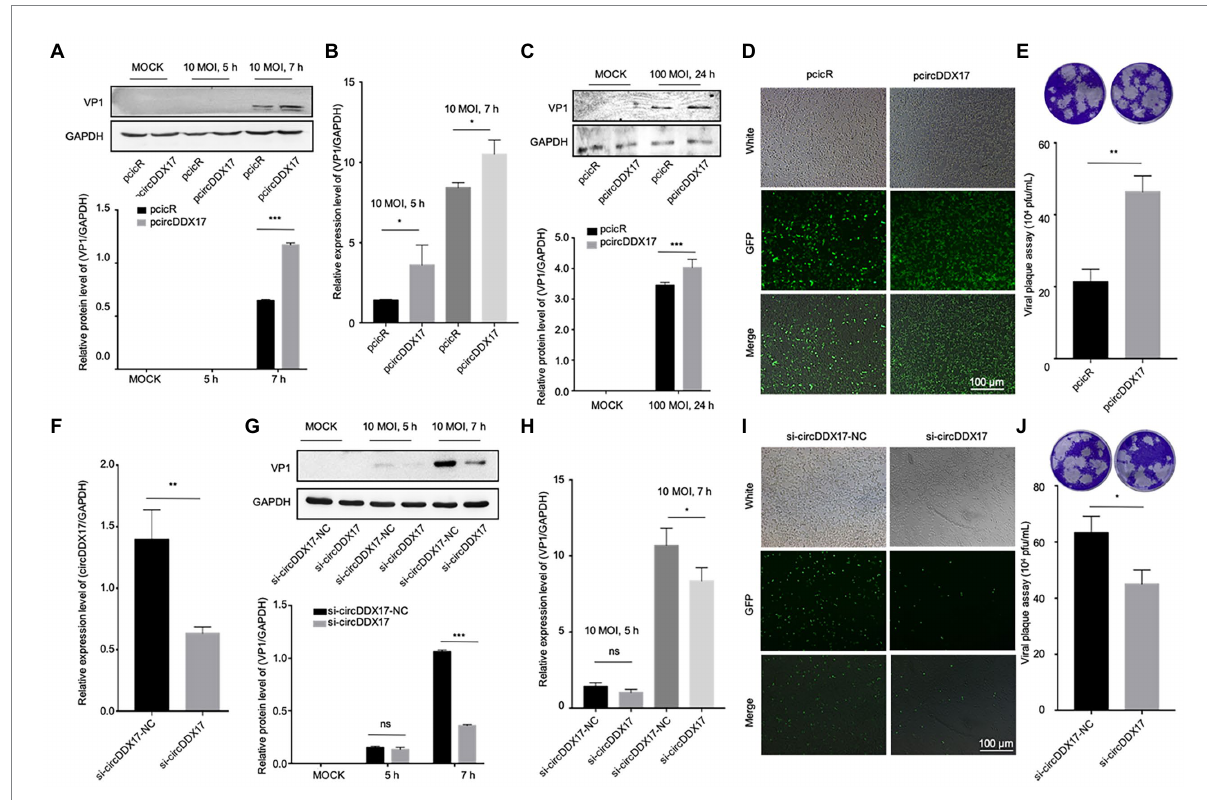
FIGURE 2 CircDDX17 promotes CVB3 replication. (A,B) Western blot and RT-qPCR of VP1 expression levels in CVB3-infected HeLa cells overexpressing circDDX17 (Western blot and analyzed using ImageJ software). (C) Western blot to analyze the expression of VP1 after HL-1 overexpression circDDX17. (D) HEK-293T cells co-transfected pcircDDX17 and GFP-CVB3, observed GFP-positive cell number after 48 h. (E) Viral plaque assay. Viral titer was determined by plaque assay using the supernatants collected at 7 h ( n = 3). (F) RT-qPCR to analyze the circDDX17 expression after si-circDDX17 transfected HeLa cells. (G,H) Western blot and RT-qPCR to detect VP1 expression in HeLa cells after transfected with the si- circDDX17 and infected CVB3 (10 MOI). (I) HEK-293T co-transfected with si-circDDX17 and GFP-CVB3, observed GFP-positive cell number after 48 h. (J) Viral titers were determined by plaque assay using the supernatants ( n = 3). * p < 0.05, ** p < 0.01, *** p <